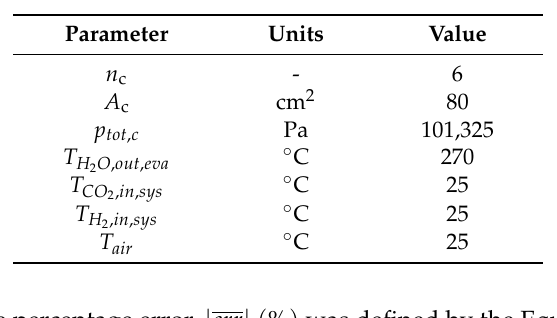
Table 4. Main input data of the calculation code.